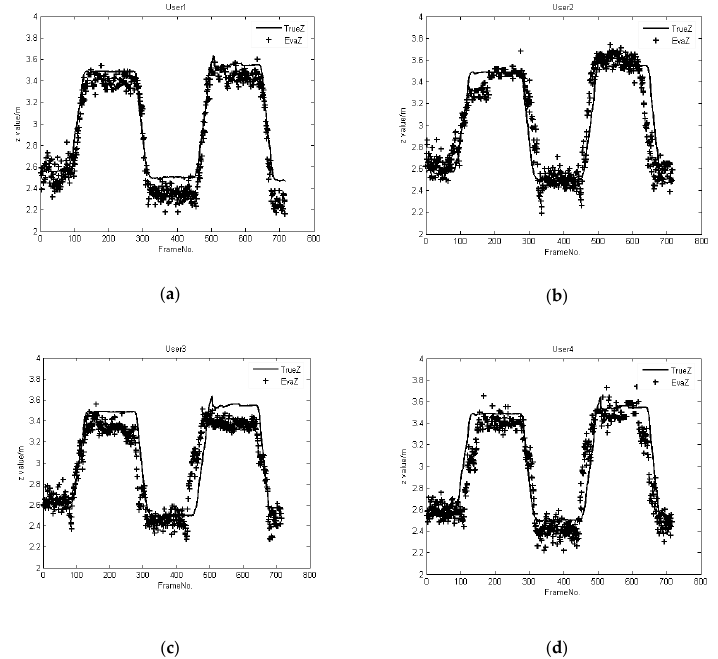
Figure 11. Comparison between trajectories as tracked by a person’s skeleton as opposed to computed using shadows for Path 1, where Users 1, 2, 3, and 4 are randomly selected human participants, and their tracking results correspond to ( a – d ), respectively.